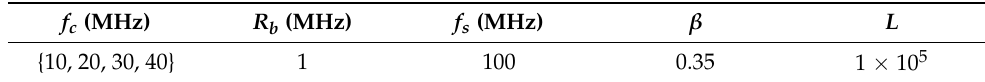
Table 1. Common simulation parameters.